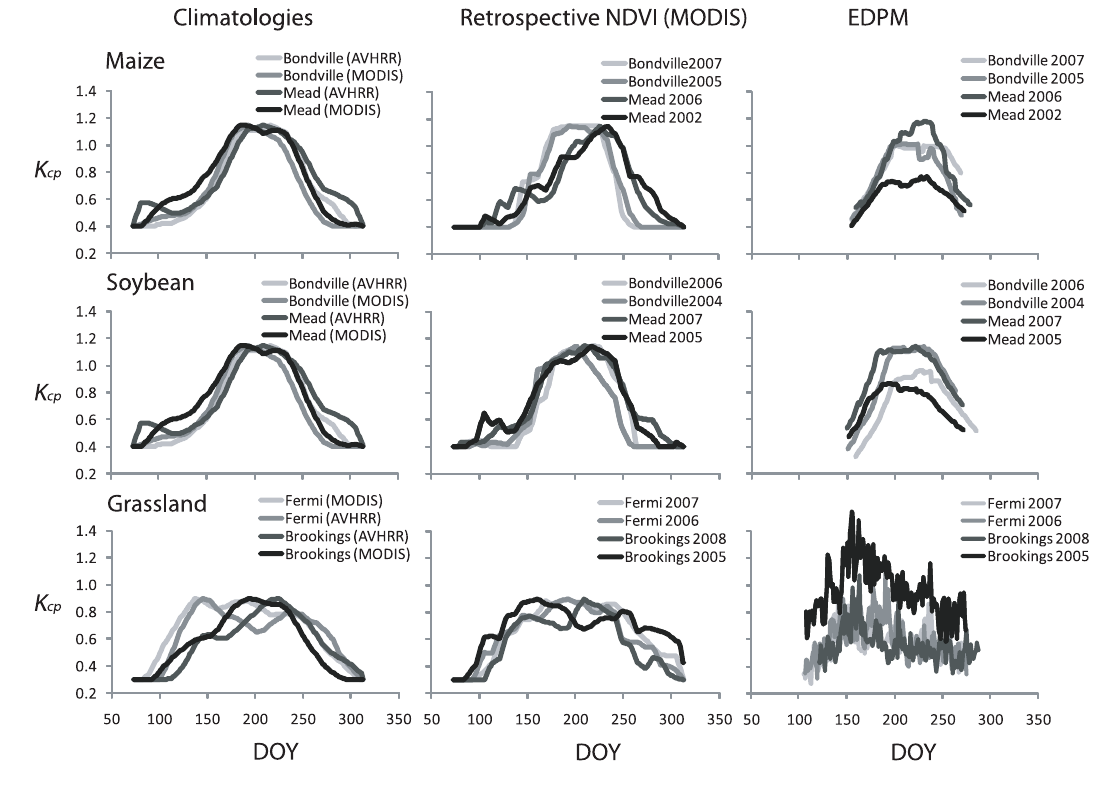
Fig. 2. Phenological parameterizations for the